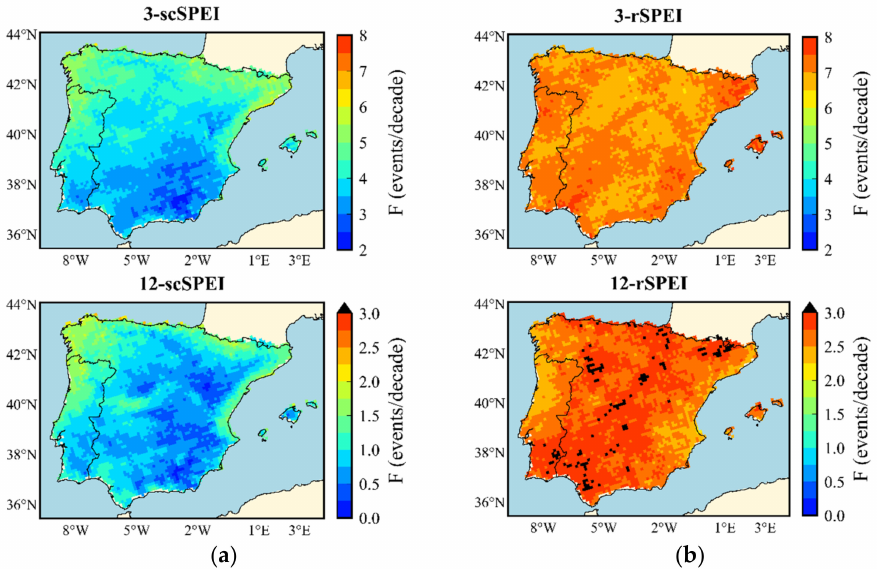
Figure 2. Multi-model ensemble mean of drought frequency (F, expressed in events per decade) for indices computed at both 3- and 12-month timescales for the recent past for ( a ) scSPEI (using 1980–2099 as reference period), and ( b ) rSPEI (with 1980–2009 as reference